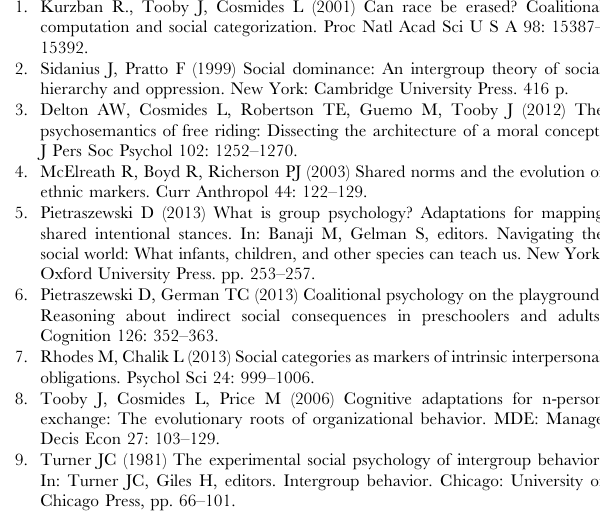
Figure S1, Coalitional categorization; charity groups present at encoding. Table S1, Racial categorization with coalitions absent (Study 1) vs. present (Study 3). Table S2, Coalitional categoriza- tion when crossed with Race (Studies 3 & 5) or Sex (Studies 4 & 6) and shirt color categorization when crossed with Race (Study 1) or Sex (Study 2), Table S3, Shirt color categorization without coalitions. Sex of participant effects, Study 1. Table S4, Gender categorization with Coalitions Absent vs. Present (Study 2 vs. Study 4,